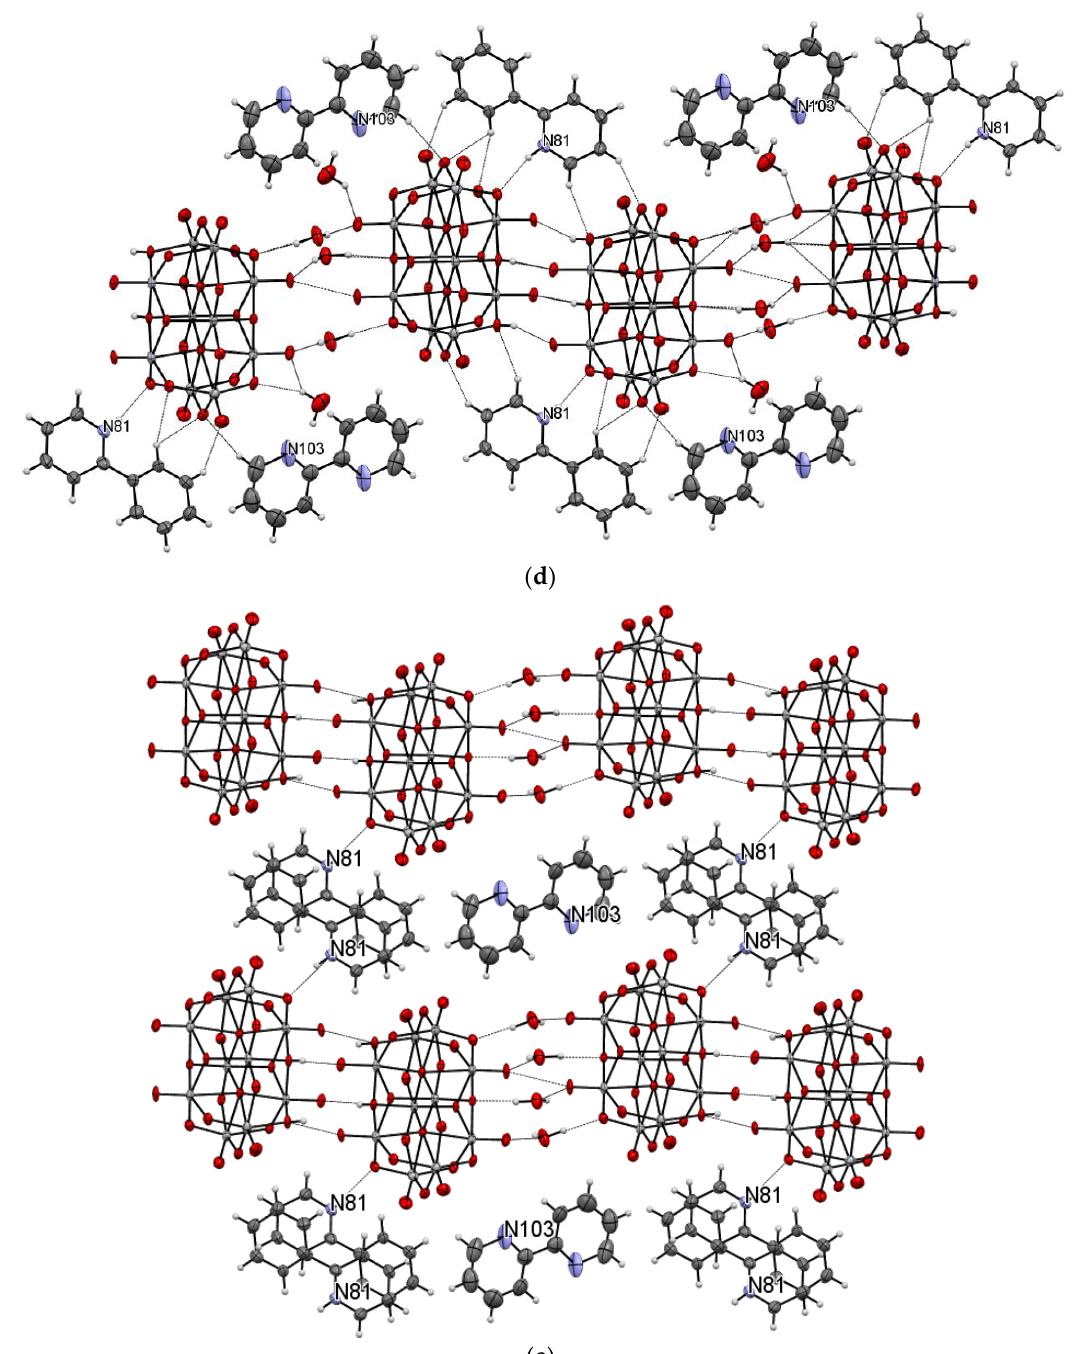
Figure 2. Self-assembly of [V 10 O 28 H 2 ] 4 − cluster (hydrogen bonds are represented by dashed lines); (a)-(e) panels exhibit various fragments of new oxovanadium(IV) microclusters with 2-phenylpyridine.